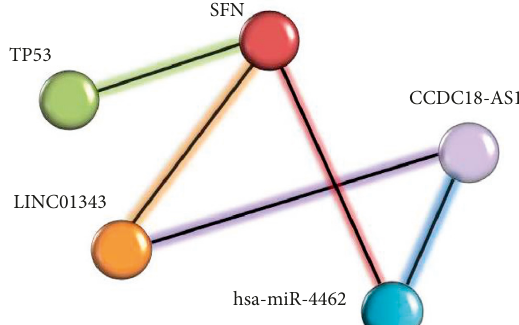
Figure 3: The novel ceRNA interaction (lncRNAs-miRNA-mRNA) associated with tumor networks of BC shows that hsa-miR-4462 and LINC01343 targeted SFN. miRNA and LINC01343 both have interaction with CCDC18-AS1.